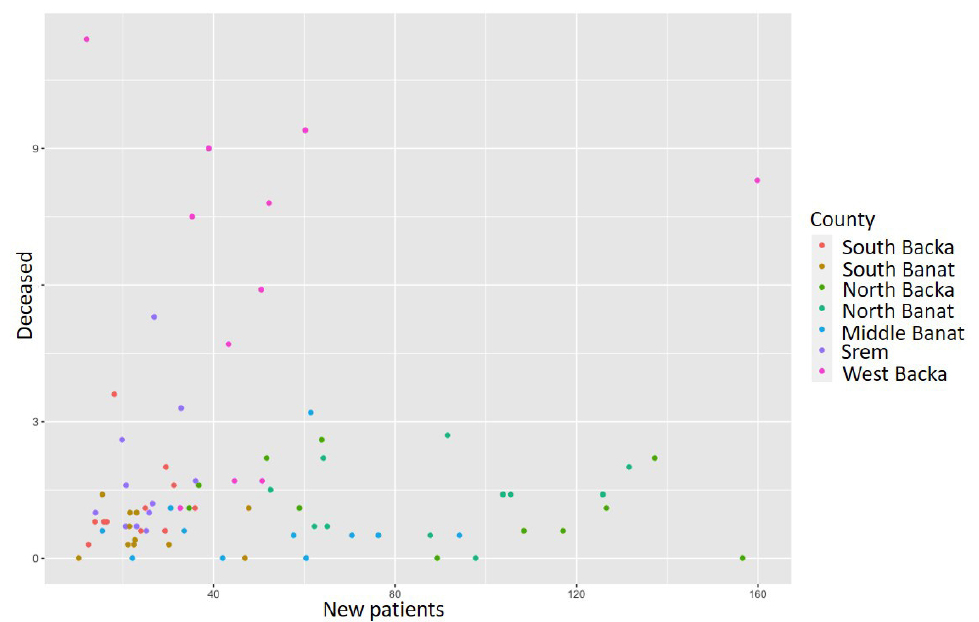
Figure 10. Unstable angina pectoris incidence and mortality rate ratio from 2010 to 2020. The application of the k-means function for the cluster analysis shows that there are three clusters (Figure 11).